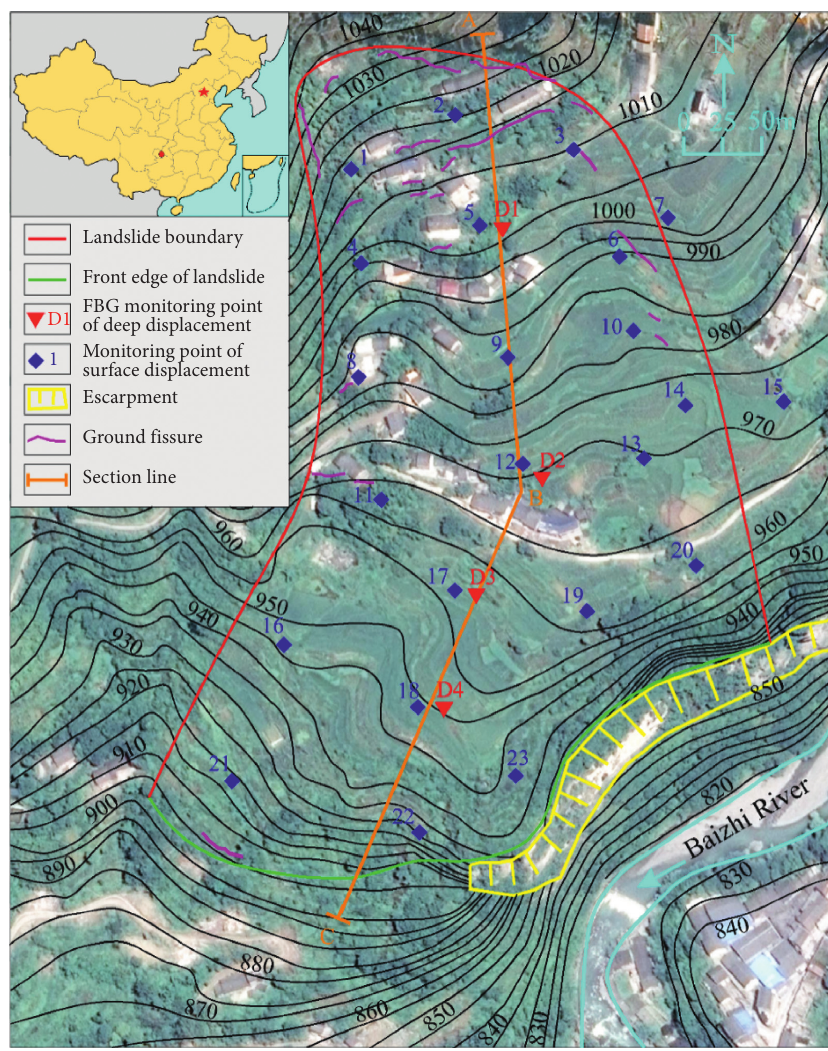
Figure 5: Layout of the Toudu landslide